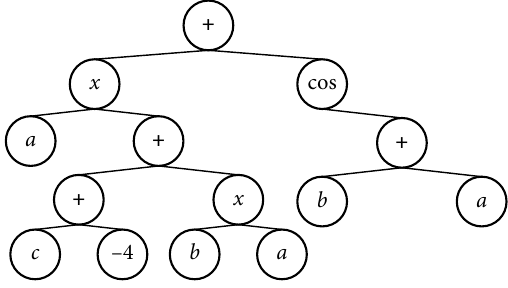
Fig. 2. Sample of Expression Trees